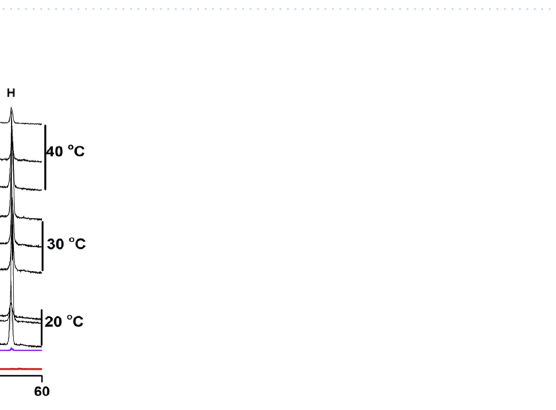
Figure 6. Effect of temperature, salinity and Mg 2 + : Ca 2 + ratio on the incorporation of Mg (%Mol Mg) into the carbonate minerals recovered from pure cultures of: DF112 ( a ) and DF 2141 ( b ), at Mg 2 + : Ca 2 + 6 and 12. Adapted from corresponding PhD dissertation 71 .